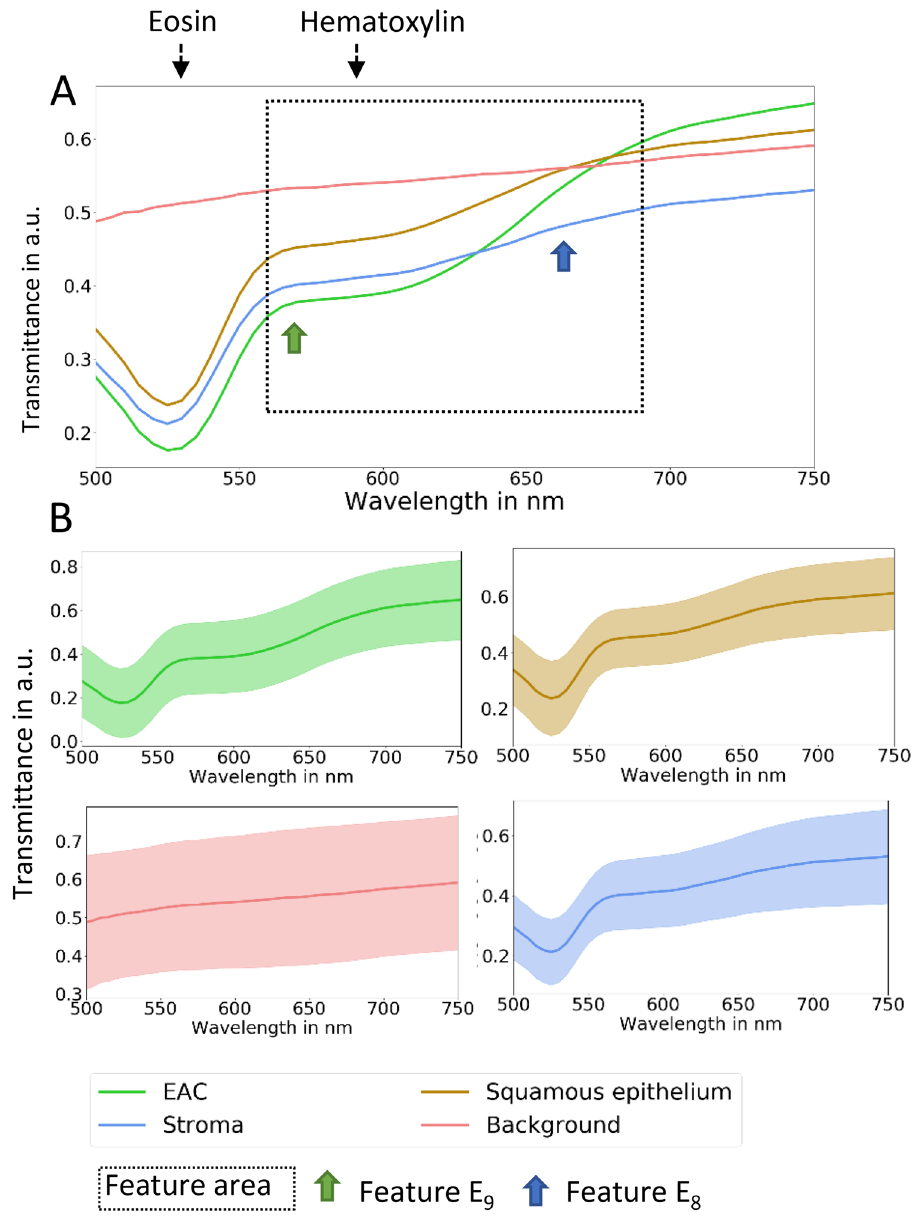
Figure 2. The mean transmittance of the spectra values of the four different classes. ( A ) The black-dotted arrows show the wavelengths of the transmittance peaks of hematoxylin and eosin. The dotted frame shows the area of the features, which were used to classify the samples. The green and blue arrows depict the feature E7 and E8, respectively. The transmittance of the background reveal a high difference to the other classes. ( B ) Mean and standard deviation of the standard normal variate (SNV) of transmittance of squamous epithelium, EAC, tumor stroma cells, and background are shown. All classes have a high standard deviation over the whole wavelength range. (a.u. - aberrante